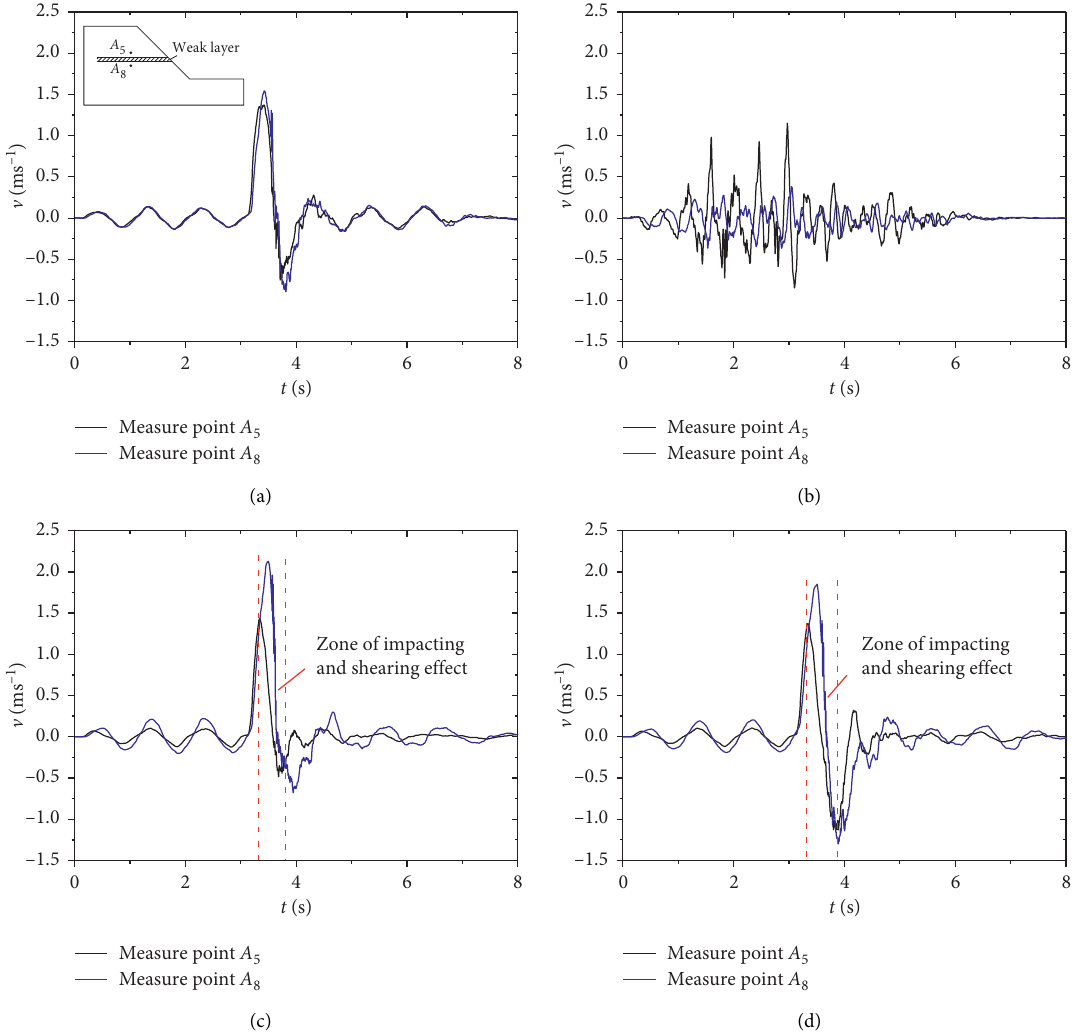
Figure 24: Velocity time history of measuring points above and below the weak interlayer. (a) Homogeneous slope under fling step. (b) Slope with a weak interlayer under pulseless ground motion. (c) Slope with a weak interlayer under fling step. (d) Slope with a weak interlayer under directivity pulse.